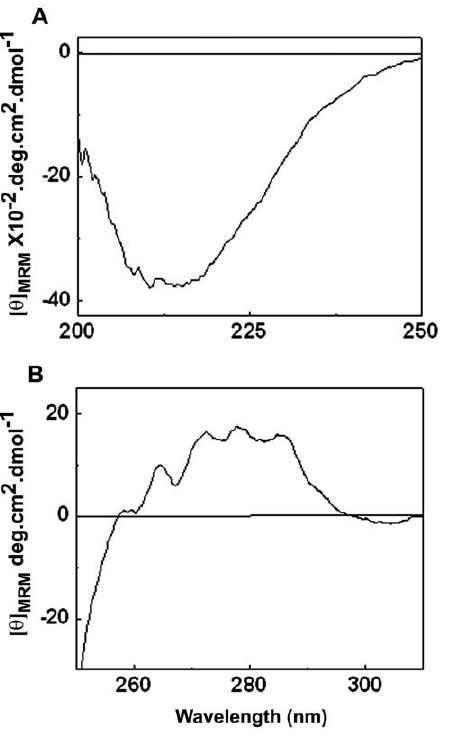
Figure 2. Far-UV (a) and near-UV (b) CD spectra of HspB2. Solid line, human HspB2; dotted line, a B-crystallin. The far- and near-UV CD spectra of the proteins, were recorded using 0.1 cm and 1.0 cm path length cuvettes respectively. [ h ]MRW is mean residue ellipticity.